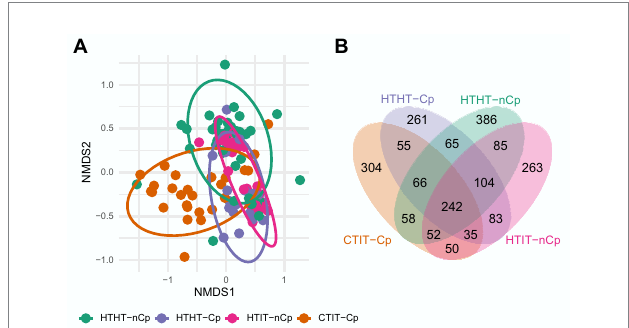
FIGURE 3 (A) Two-dimensional nonmetric multidimensional scaling (NMDS) plot of fungal communities in relation to sample type HTHT-nCp (healthy tissue from healthy trees without C. parasitica ), HTHT-Cp (healthy tissue from healthy trees with latent C. parasitica infection), HTIT-nCp (healthy tissue from C. parasitica infected trees) and CTIT-Cp (canker tissue from C. parasitica infected trees); 2-D-stress value: 0.21. (B) Venn diagram showing shared and exclusive OTUs for the different sample